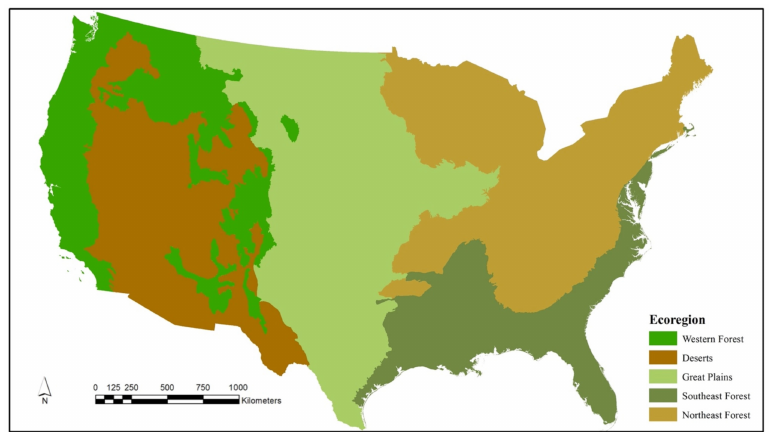
Figure 3. The five ecoregions used for HCI calibration. These ecoregions are based upon NatureServe EcoDivisions (Comer & Schulz 2007) and represent subcontinental landscapes with generally similar ecological and climatological processes. A separate HCI map was created for each ecoregion shown that allowed model parameters (e.g., slope) for each of the four component layers (e.g., fragmentation) to vary by